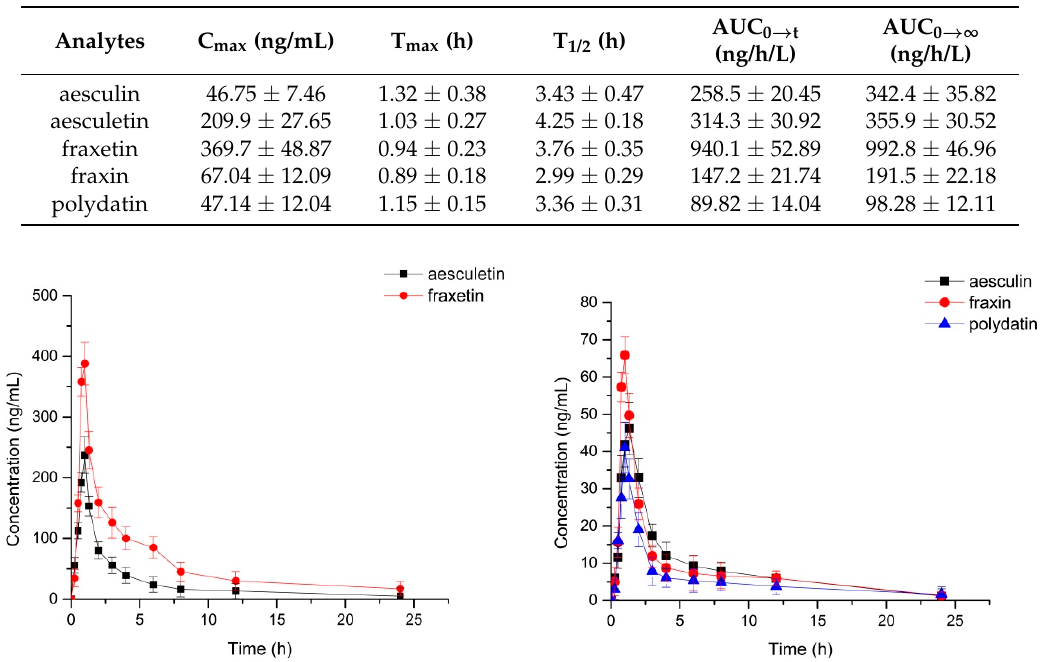
Figure 3. Mean plasma concentration–time profiles of aesculin; aesculetin; fraxetin; fraxin; polydatin in beagle dog plasma after oral administration of the extract of L. palustre (n = 6, Mean ±